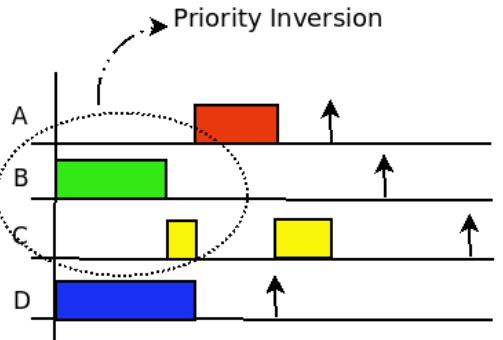
Figure 2. Priority inversion in Server 1. A red, B green, C yellow and D